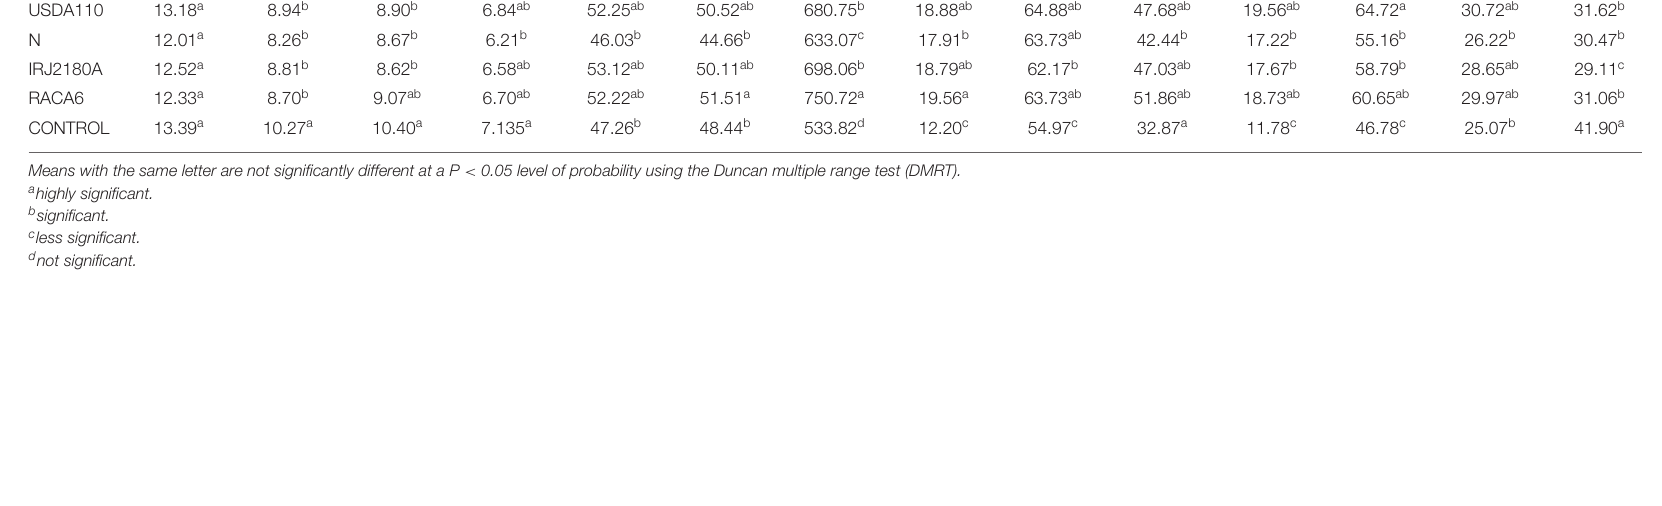
TABLE 11 | Analysis of accessions inoculated with B. japonicum strains in Ibadan and Ikenne locations during both seasons. Source